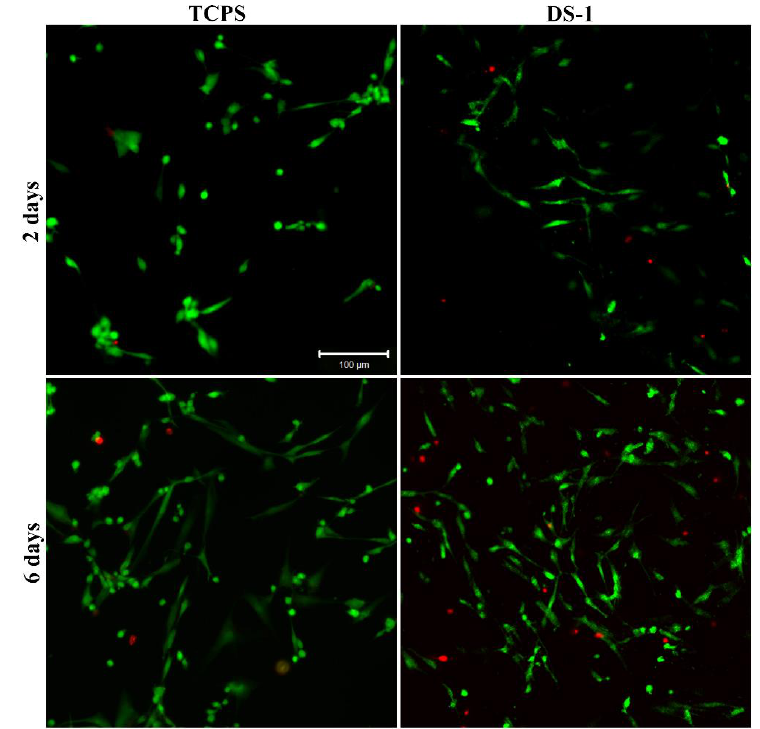
Figure 8. Confocal microscopy of live (green) and dead (red) cells cultured in contact with DS-1 for two and six